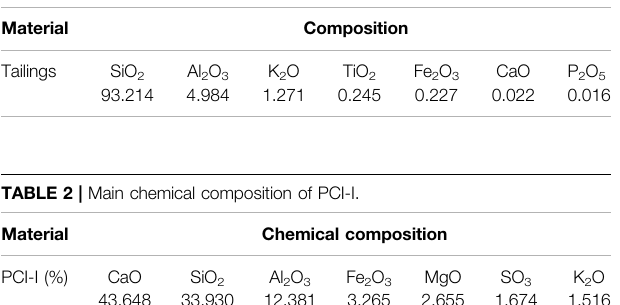
TABLE 1 | The main chemical composition of tailings.